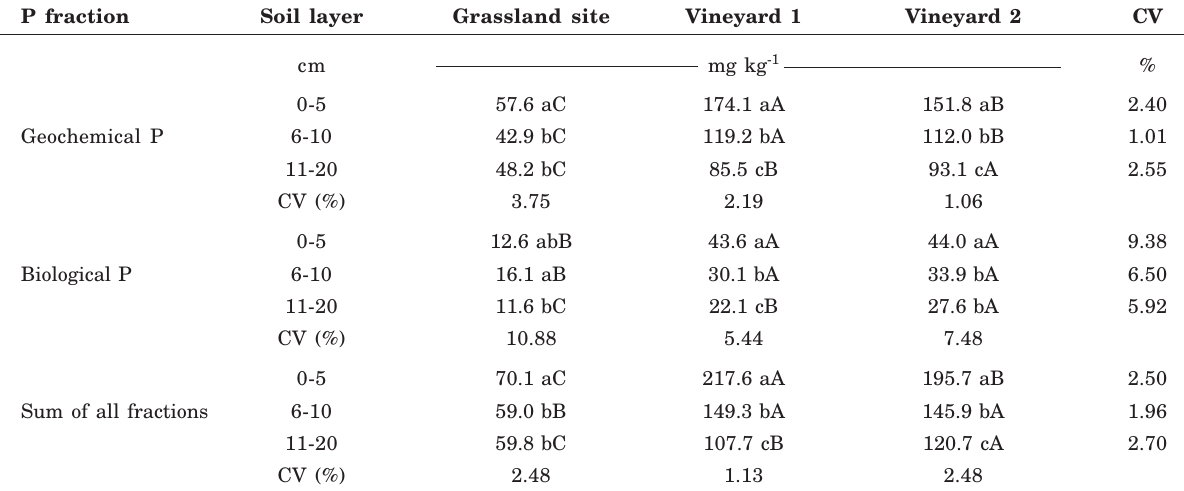
Mean values followed by the same letter in the column and mean values followed by the same capital letter in the row, comparing soil layers, are not significantly different (Tukey test,